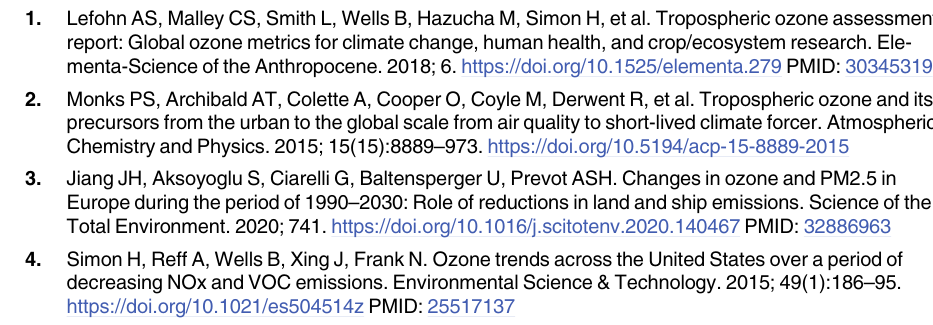
of FM). S1 Table. Evolution of chloroplast size and shape in the leaf mesophyll of hybrid poplar trees ( Populus tremula x alba ) in response to O and assessment time. Values represent mean ± SE, n = 4. Different letters indicate significant differences between treatments for a given assessment date (Tukey’s honestly significant differ- ence post-hoc test, P � 0.05). (model implemented in R: lmer(variable ~ O position � time + mesophyll layer +(1 |